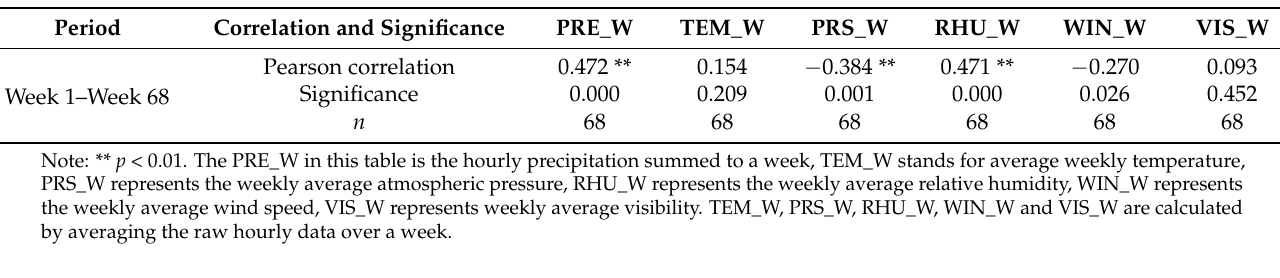
Table 5. Correlation analysis of weekly data of NAI concentrations with meteorological factors.